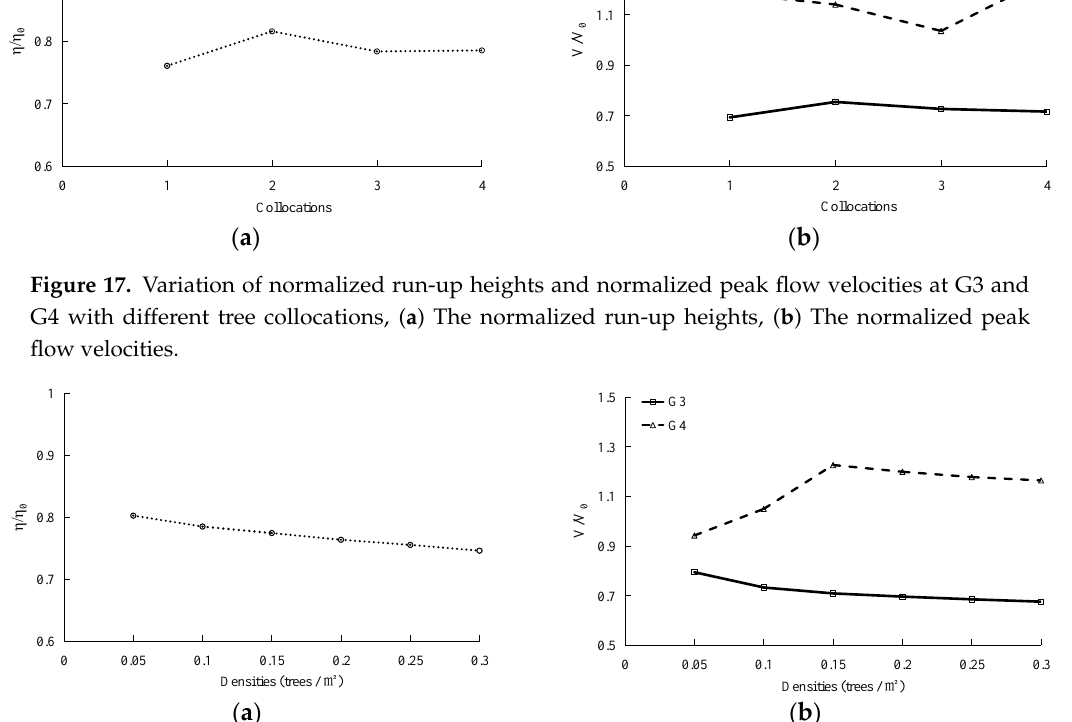
Figure 18. Variation of normalized run-up heights and normalized peak flow velocities at G3 and G4 with different densities of pure P. odoratissimus. ( a ) The normalized run-up heights, ( b ) The normalized peak flow velocities.